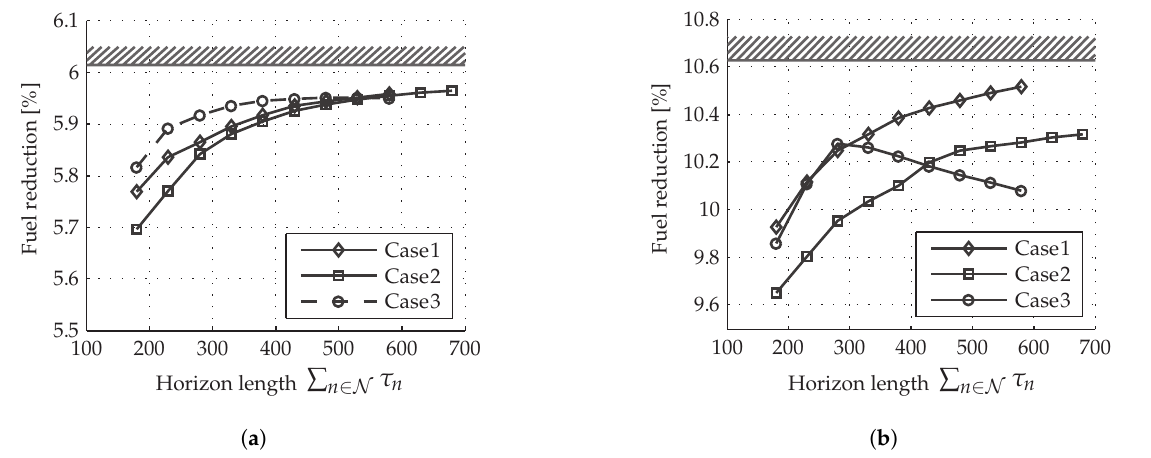
Figure 5. Fuel reduction of a hybrid heavy-duty vehicle for two parts of the drive cycle and various cases. ( a ) Part 1; ( b ) Part 2.